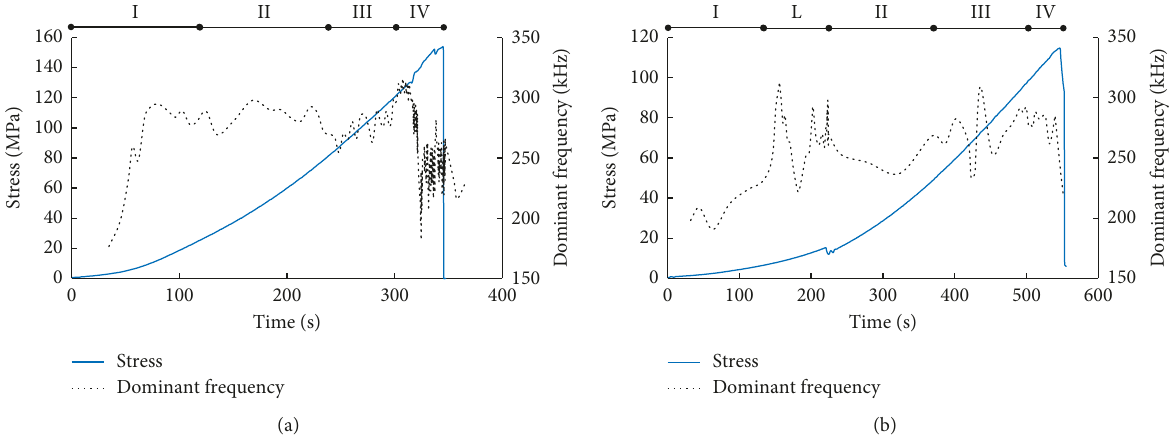
Figure 3: Changes of stress and dominant frequency with time: (a) Sim2; (b) Sim10.